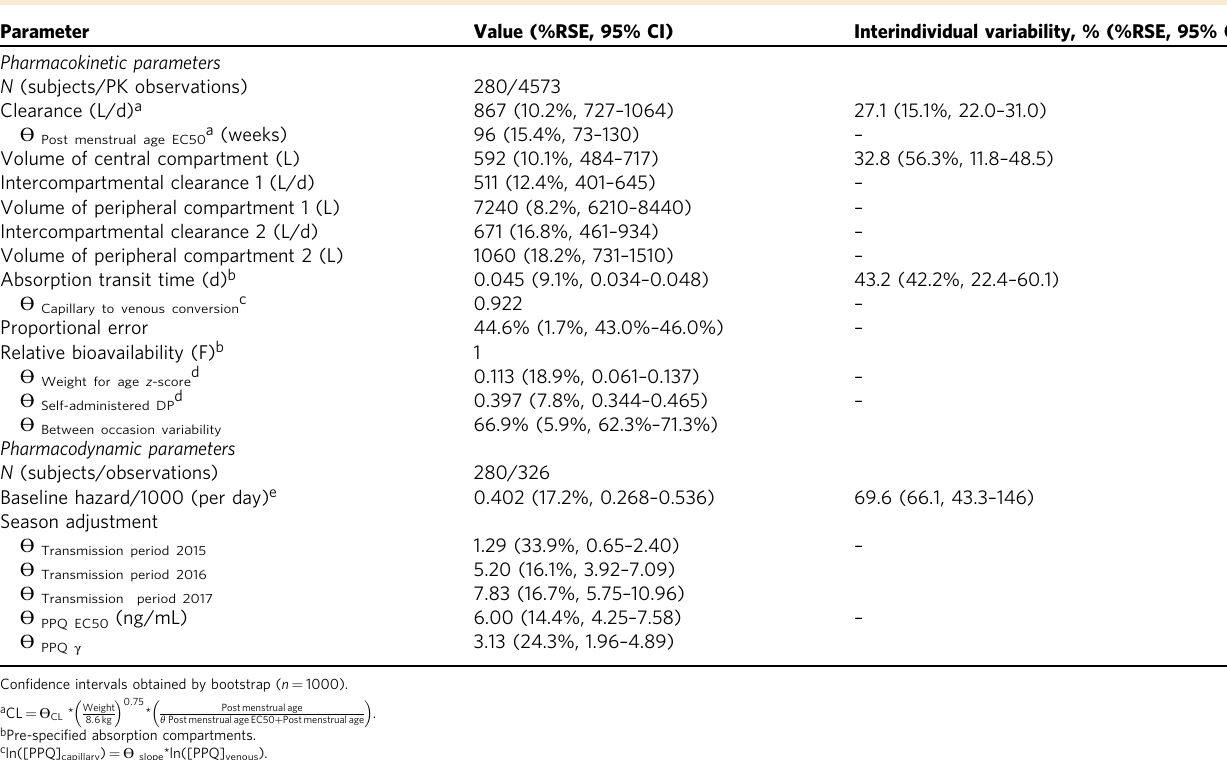
Table 2 Pharmacokinetic and pharmacodynamic